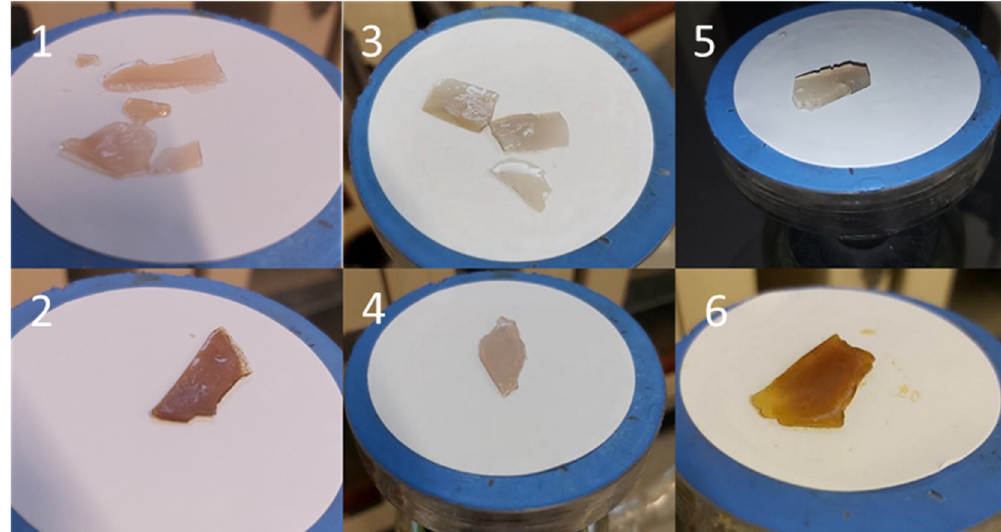
Figure 7. Swollen appearance of various silver salt loaded CNC films. (1) silver nitrate with CNC, (2) silver nitrate with CNC and glycerol, (3) silver sulphate with CNC, (4) silver sulphate with CNC and glycerol, (5) silver acetate with CNC, (6) silver acetate with CNC and glycerol.